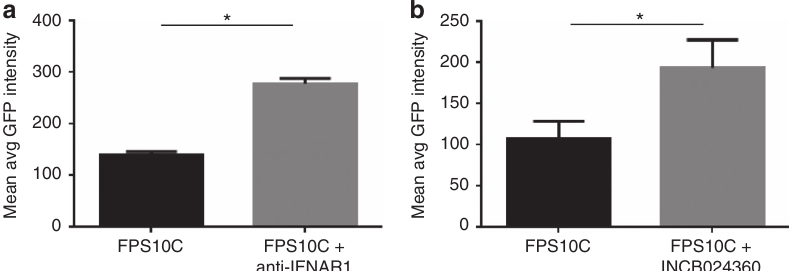
Figure 5 | Effect of inhibitors on C. trachomatis infection of human iPSdMs. ( a ) Anti-IFNAR1 antibody; ( b ) IDO inhibitor INCB024360. Results are the average of three independent measurements ± s.d. using the Cellomics CellInsight NXT. *Represent statistically significant different ( P o 0.05) between untreated and treated as determined using two-way